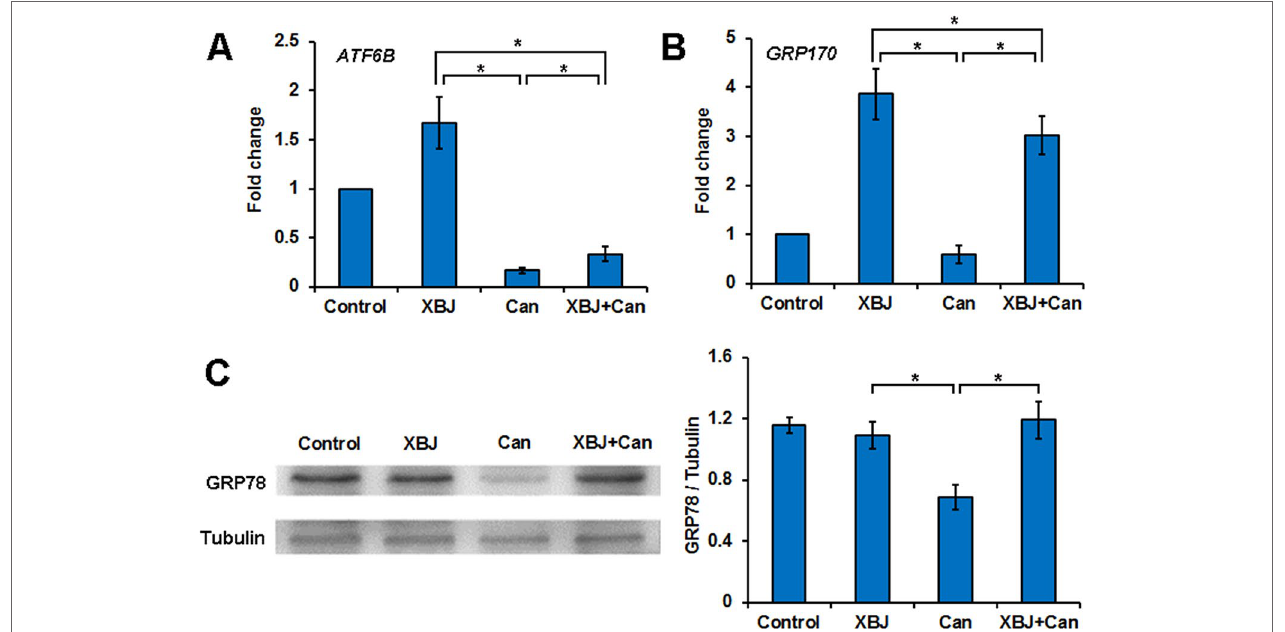
FIGURE 6 | XBJ up-regulates the ER stress signaling pathway during C. albicans infection. Six groups of 293T cells in different conditions were subjected to RNA- seq analysis, including cells treated with XBJ only, infected with C. albicans , 293T cells infected with C. albicans in the presence of XBJ (1:100 dilution). (a , B) RNA- seq results of ATF6B and GRP170, two genes in the ER stress pathway. (C) Western blot to determine the expression of GRP78 expression in different conditions in 293T cells. Data were representative of at least three independent experiments. *P < 0.05.